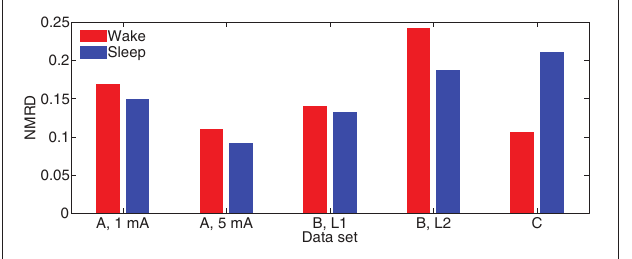
FIGURE 9 | Normalized mean-squared one-step prediction error [see Equation (25)] in each dataset.